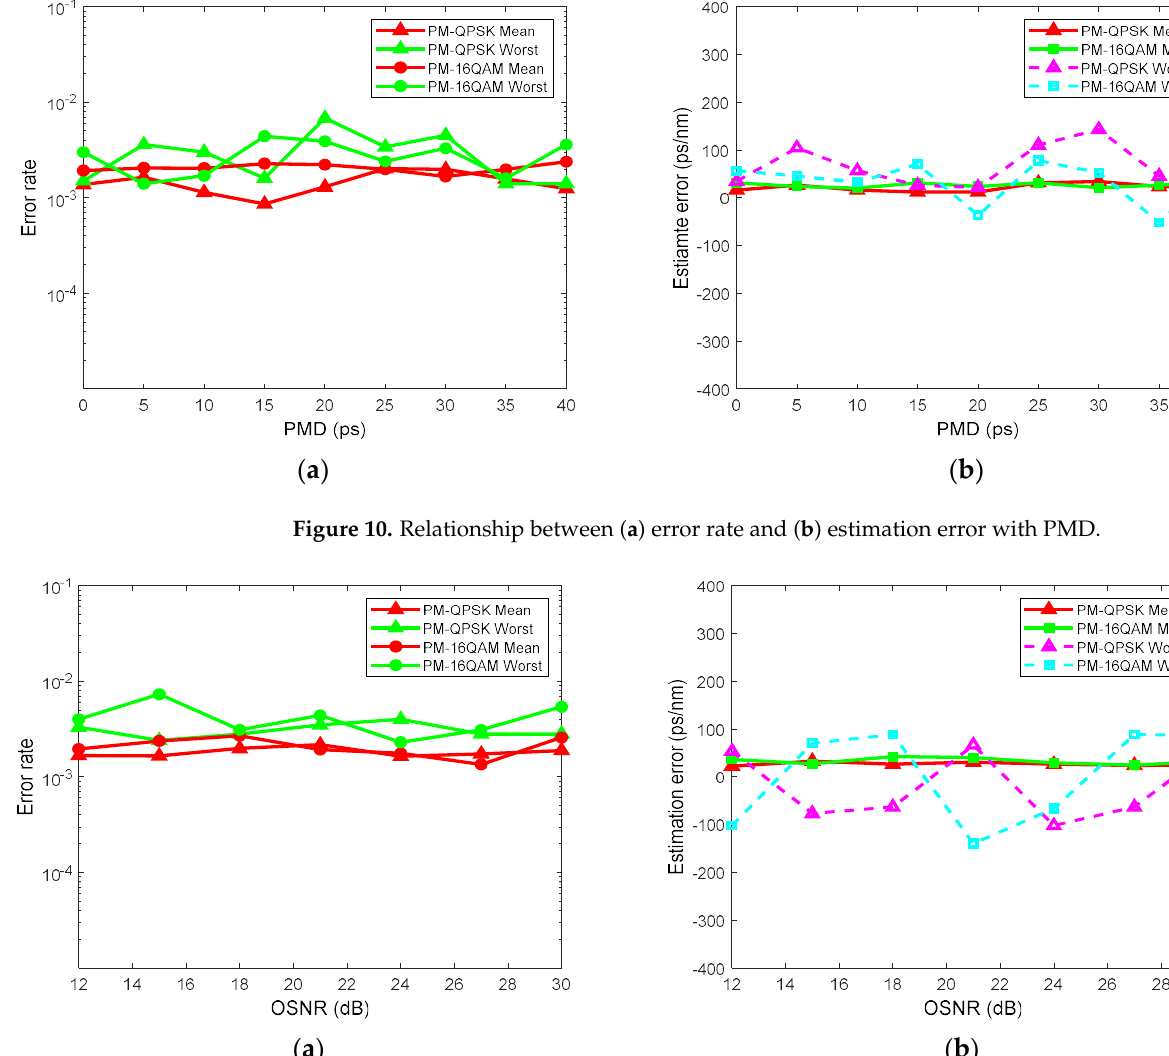
Figure 10. Relationship between ( a ) error rate and ( b ) estimation error with PMD.